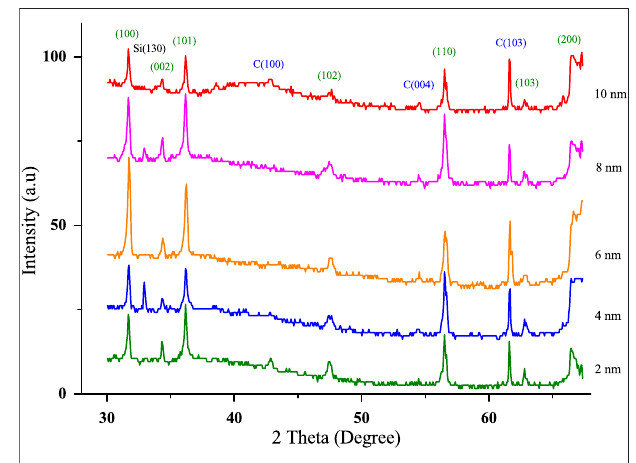
FIGURE 5 | SEM image of MWCNTs.